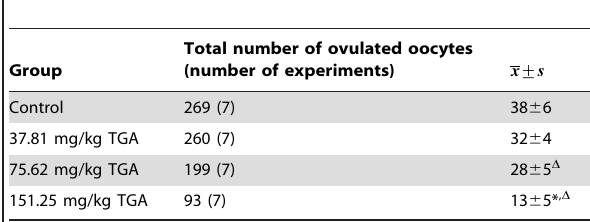
Table 1. Effect of TGA on the number of ovulated oocytes.